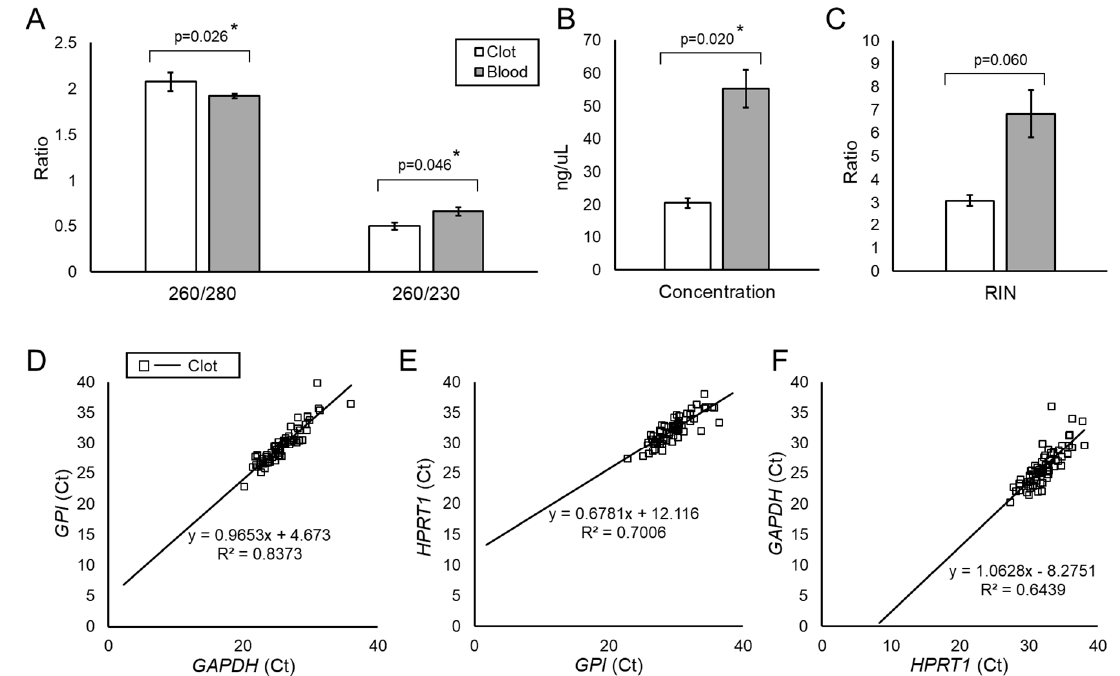
Figure 1. RNA Quality and qPCR Analysis. ( A ) . Average 260/280 and 260/230 ratios for clot RNA and whole blood extracted on the PerkinElmer Chemagic 360. Both sample types show 260/280 close to 2.0 (indicating RNA), but lower 260/230 ratios, indicating potential carryover of reagents from processing. ( B ) . Blood RNA showed significantly higher average concentrations than clot RNA. ( C ). Blood RNA also had significantly higher average RIN values than clot RNA. ( D ). Ct values from GAPDH and GPI amplification plotted against each other for each clot RNA sample show a correlation on linear regression analysis (R 2 = 0.84). A similar trend was present for ( E ). HPRT1 vs. GPI (R 2 = 0.70) and ( F ). GAPDH vs. HPRT1 (R 2 = 0.64). Error bars represent standard error. “*” indicates statistical significance, p < 0.05 from Student’s t -test. (Abbreviations: qPCR = quantitative polymerase chain reaction; RIN = RNA integrity number). Table 2. RNA Quantity and Quality. * Sample ID